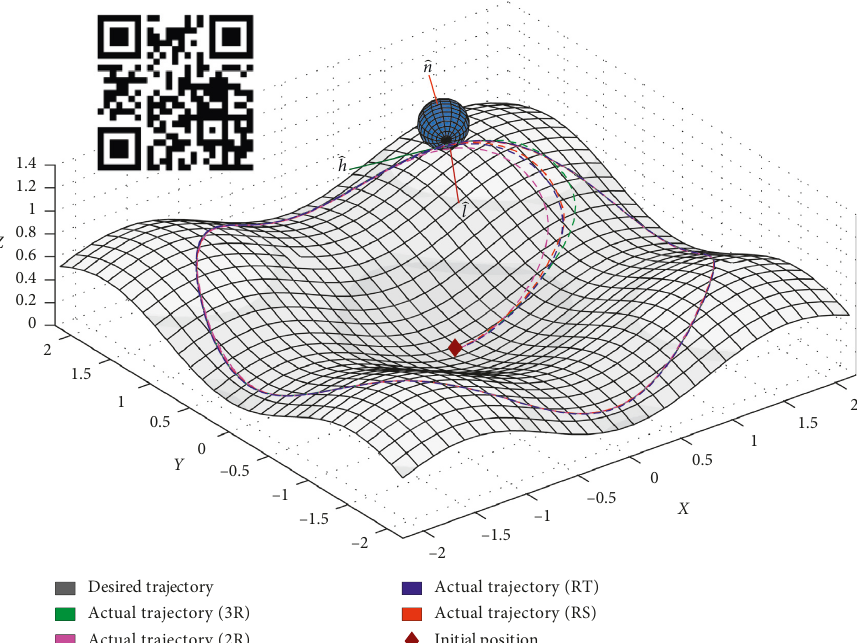
Figure 6: Robots’ actual and desired trajectories on a 3D surface for a smooth circular path. Scan the QR-code to watch an animation of the same simulation result.